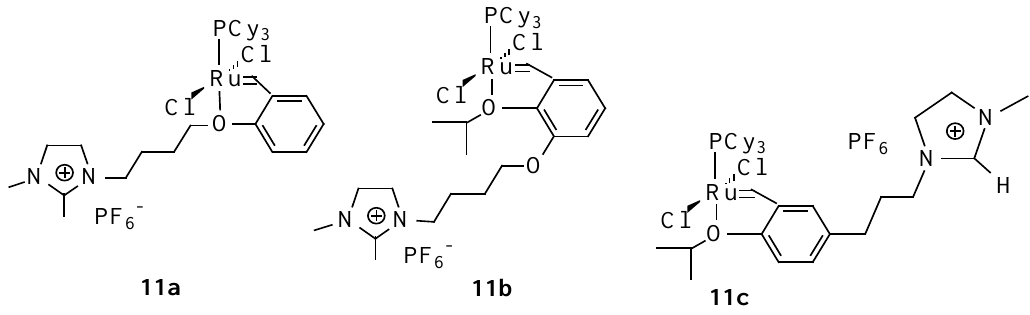
Figure 6. Hoveyda-type catalysts bearing an ionic tag [63].